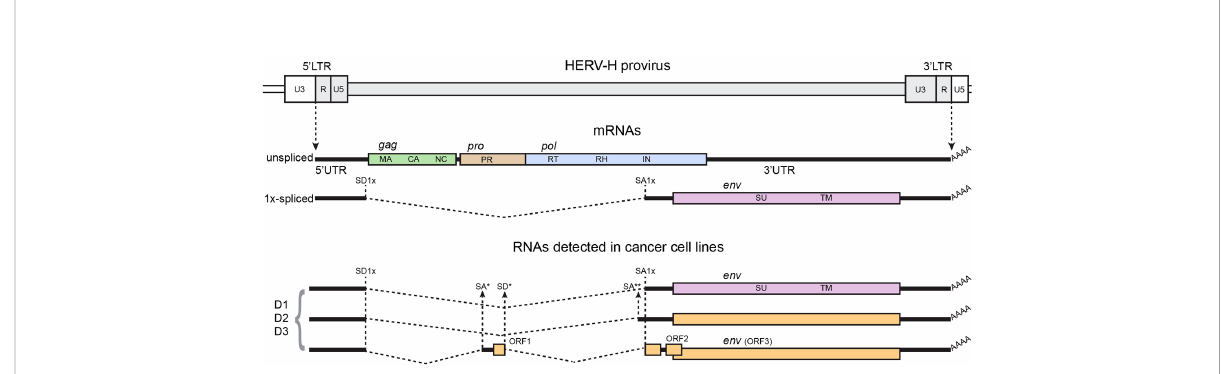
FIGURE 1 Structure of the HERV-H genome, canonical spliced mRNAs, and spliced RNAs detected in (113), from which the fi gure was adapted. A genetic map of a HERV-H provirus (gray) inserted into fl anking host genome sequences is shown. The unspliced primary viral transcript and singly spliced env mRNA are shown below the viral genome. Poly (A) tails are indicated (AAAA). The dashed, angled line shows the excised intronic sequences. Colored boxes indicated the different genes, indicated in the fi gure by name and ORF. Splice donor (SD) and splice acceptor (SA) sites are indicated on map, including canonical sites for 1x-spliced mRNA (SD1x and SA1x) and canonical sites for 2x-spliced mRNAs (SD2x ’ for type I proviruses, SD2x ” for type II proviruses, and SA2x), and individual alternative SD/SA are identi fi ed by stars (*, **). Black vertical dashed lines identify canonical SD/SA sites across the panel; black arrows show alternative SD/SA sites. D1, D2, and D3 are fi ctitious names of individual HERV-H viruses detected in the